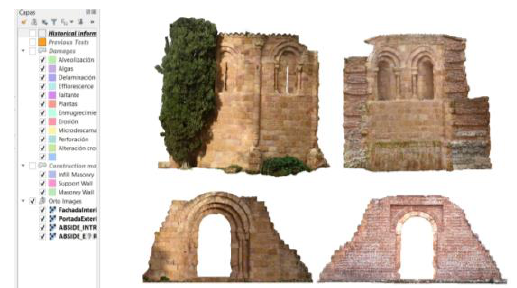
Figure 6. Ortoimages introduced within the QGIS